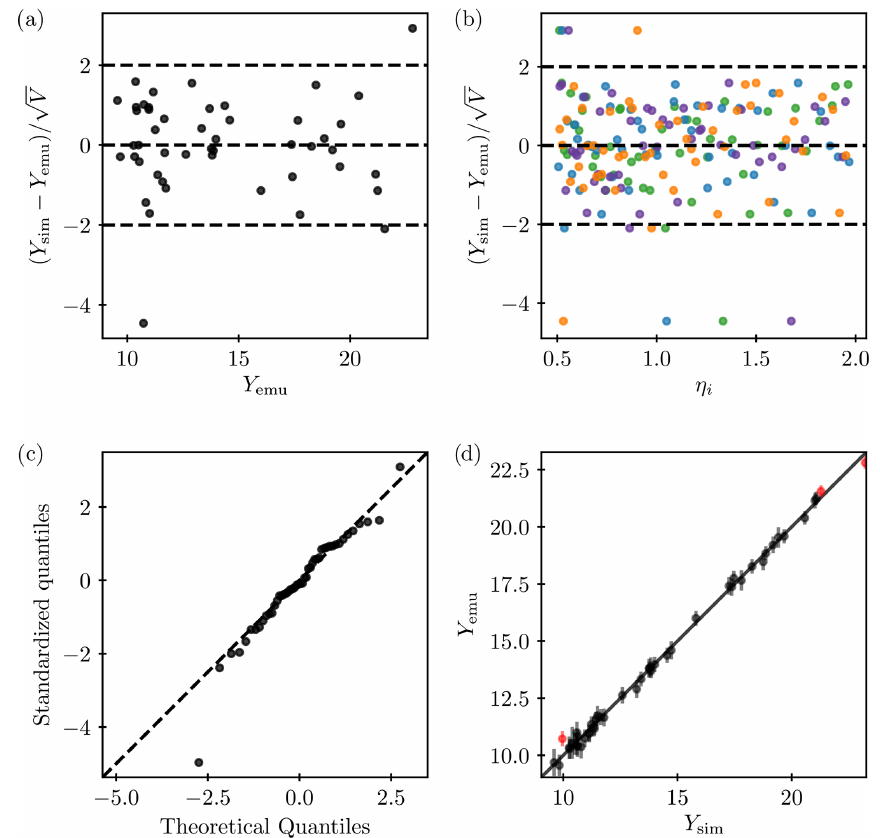
Figure 4. Leave-one-out validation of the emulator for global annual mean IWP. Each point corresponds to the training of the emulator on all points except one and then testing on exactly that point. Individual standardized errors are plotted against (a) emulator output and (b) input parameters (colors according to Fig. 5: autoconversion – blue, accretion – purple, riming – green, self-collection – orange). The dashed lines are drawn at an individual standardized error of zero and 2, which is the threshold discussed in Bastos and O’Hagan (2009). (c) Q–Q plot of the individual standardized errors against a Student’s t distribution. (d) Emulator against model output, with the error bars indicating the 95% confidence interval on the emulator predictions. Predictions for which the model result lies outside that interval are marked